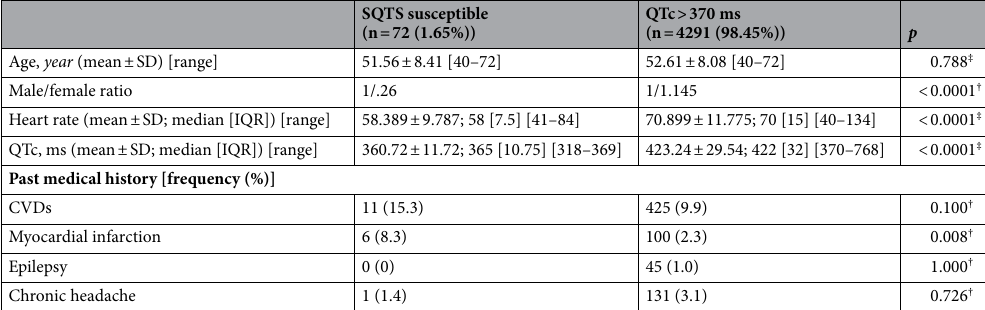
Table 2. Comparing baseline demographic, clinical and ECG-derived variables between SQTS susceptible subjects with those with QTc > 370 ms. CVDs (cardiovascular diseases), SD (standard deviation), ECG (electrocardiogram), IQR (interquartile range), p ( p -value). † Fisher’s Exact test; ‡ Independent t